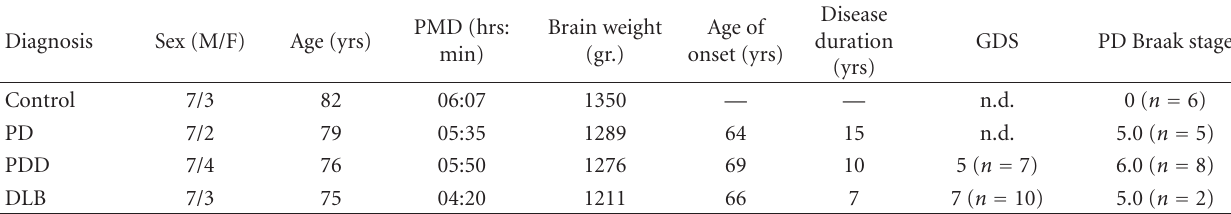
Table 1: Clinicopathological data per